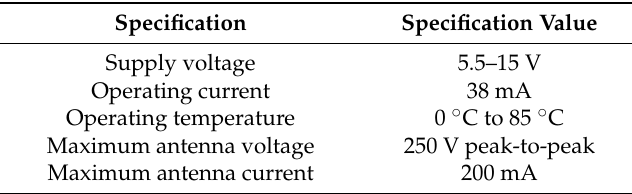
Table 1. RFID reader